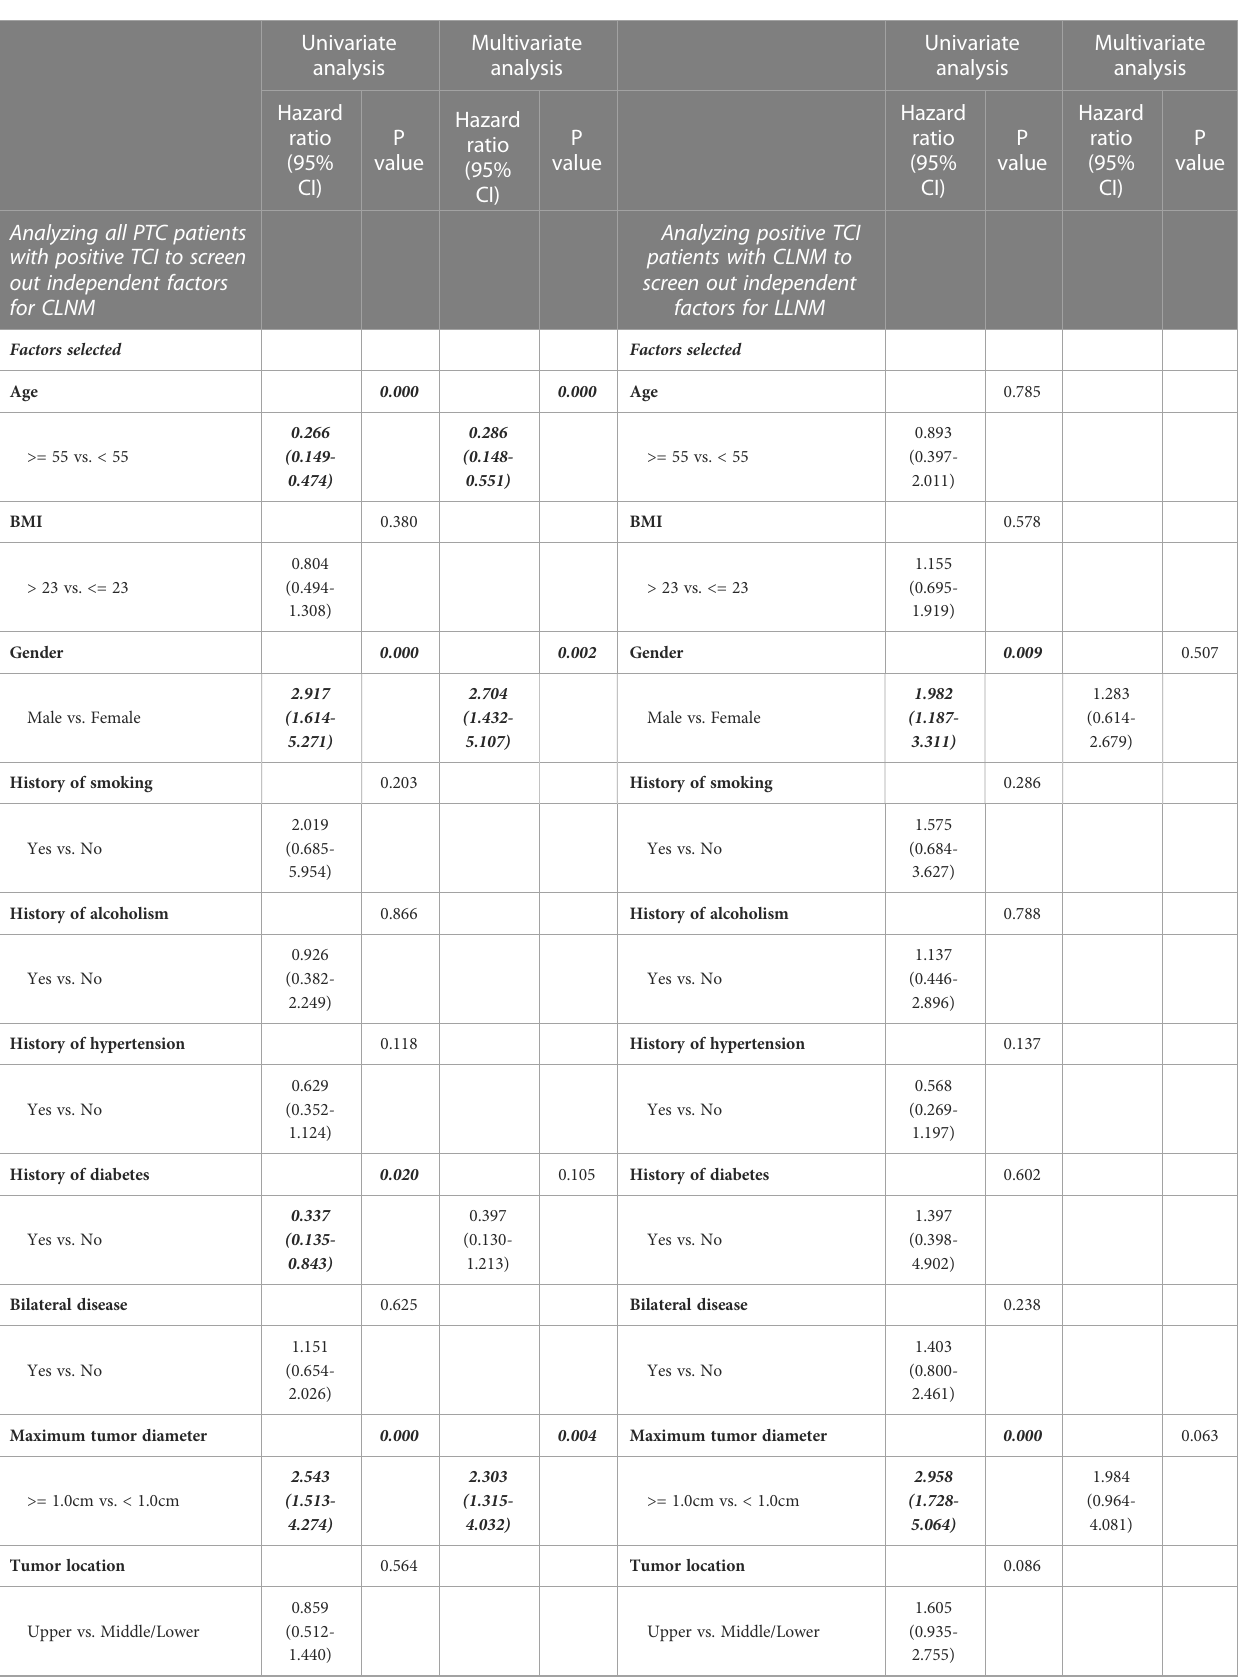
TABLE 3 Univariate and multivariate analyses for PTC patients with positive